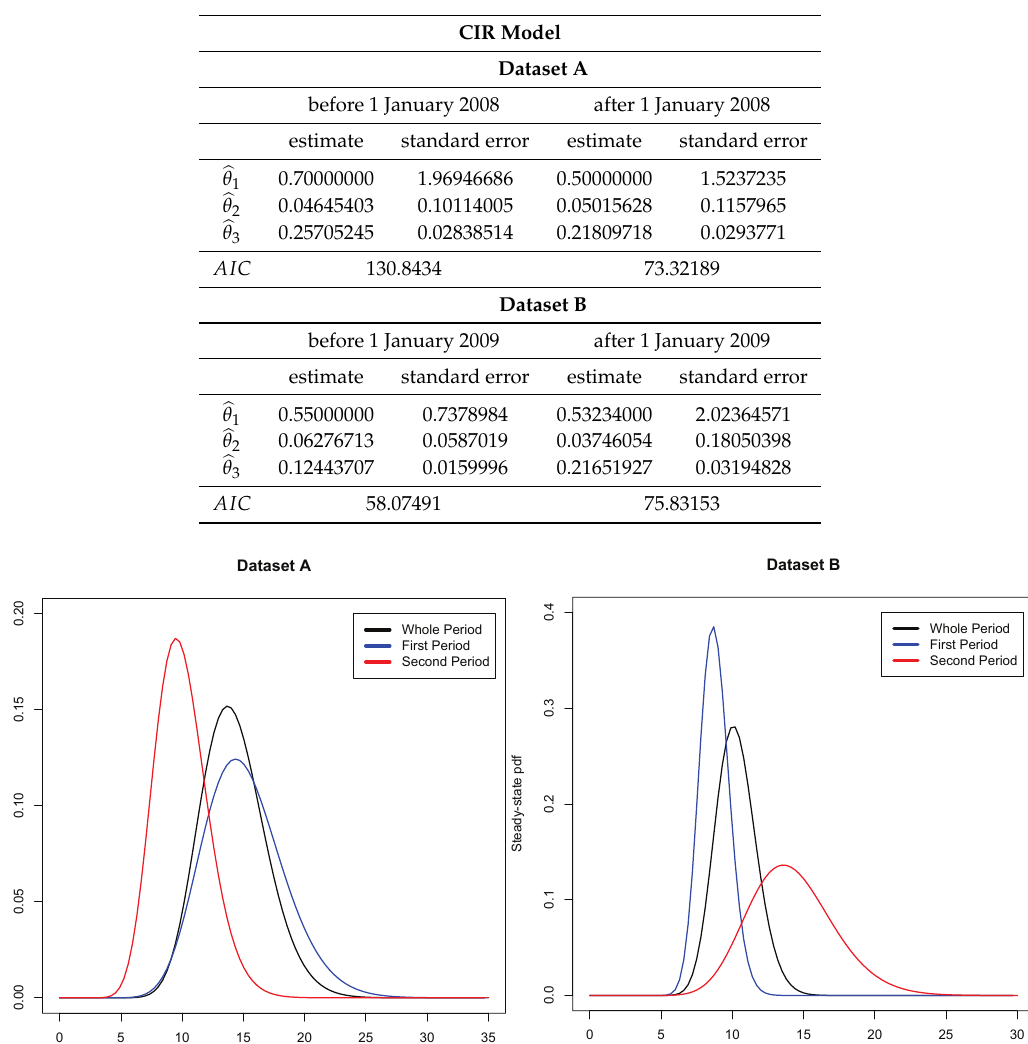
Table 4. ML estimates of Model (7) and the corresponding AIC for the periods indicated by the Chow test for Dataset A (on the top) and for Dataset B (on the bottom).